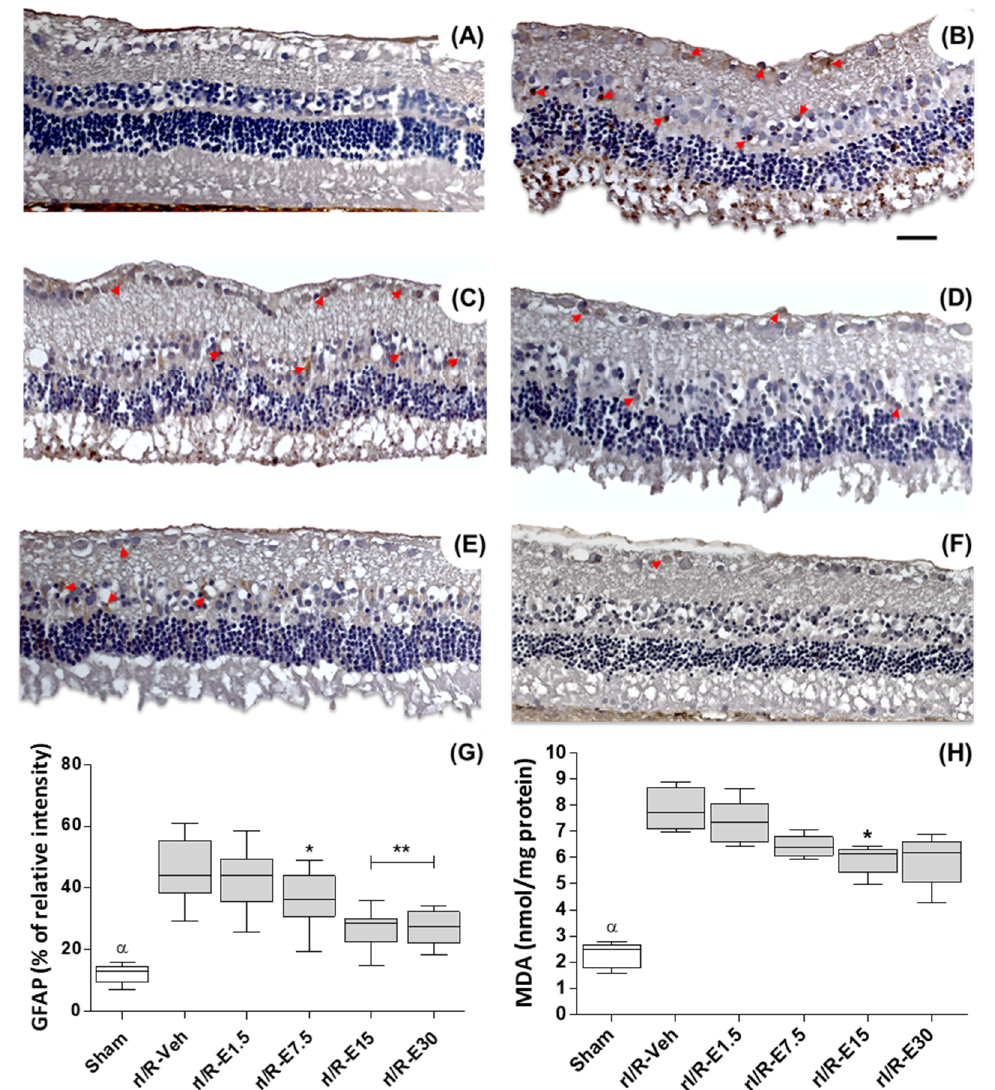
Figure 2. Effect of EGCG concentration on retinal protection at 48 h after rI/R. Gliosis retinal was measured by glial fibrillary acidic protein (GFAP) immunostaining (red arrows show representative cells). Lipid peroxidation levels were determined by malondialdehyde formation (MDA) assay. ( A ) sham group; ( B ) rI/R-veh; ( C ) rI/R-E1.5; ( D ) rI/R-E7.5; ( E ), rI/R-E15, and ( F ) rI/R-E30. The ( G ) and ( H ) show the Box-and-whisker plot (median, first-third quartile, minimum- maximum value) with the percentage of GFAP staining intensity and MDA formation levels, respectively. * p < 0.05, ** p < 0.01 compared to rI/R-veh, and α p < 0.01 compared to all groups. Scale bar = 100 μm.